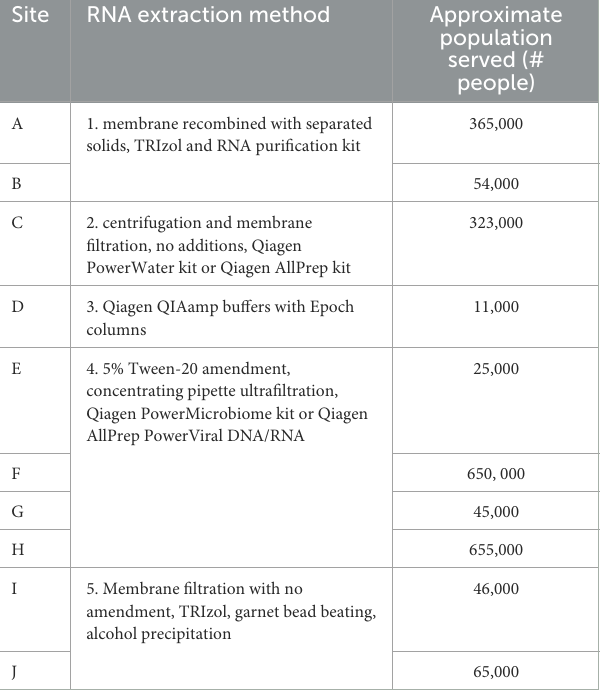
population served (#